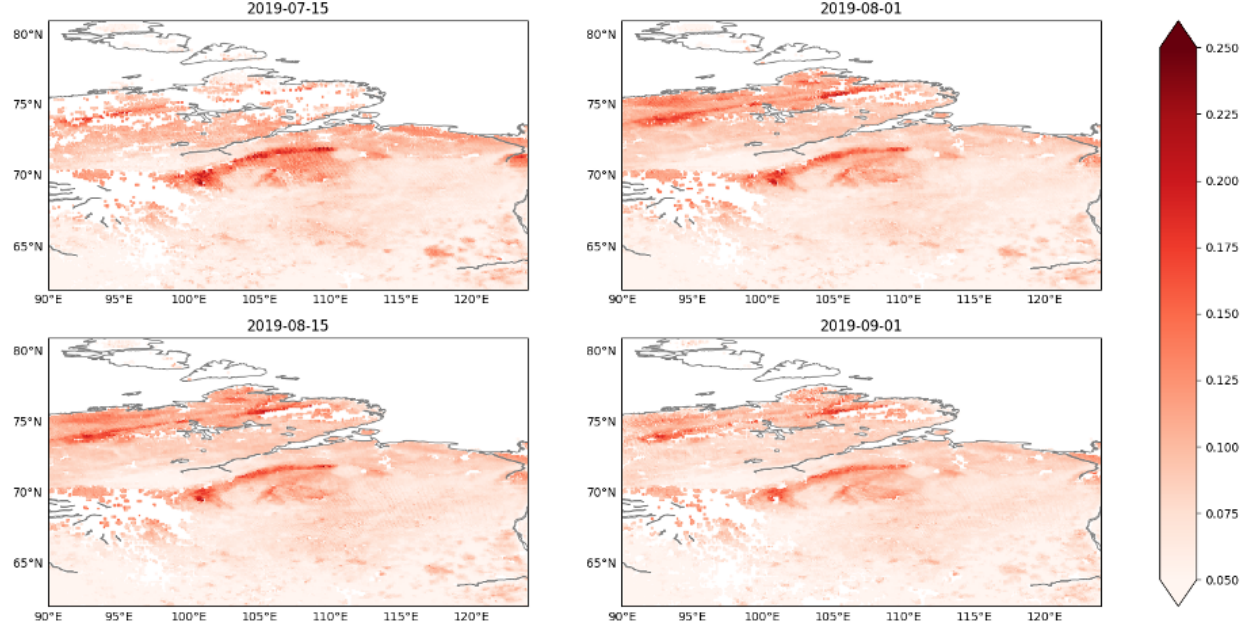
Figure 16. Albedo in the shortwave-infrared (SWIR) band over Siberia, as provided by TROPOMI. Maps display averages for the same windows as shown in Fig.